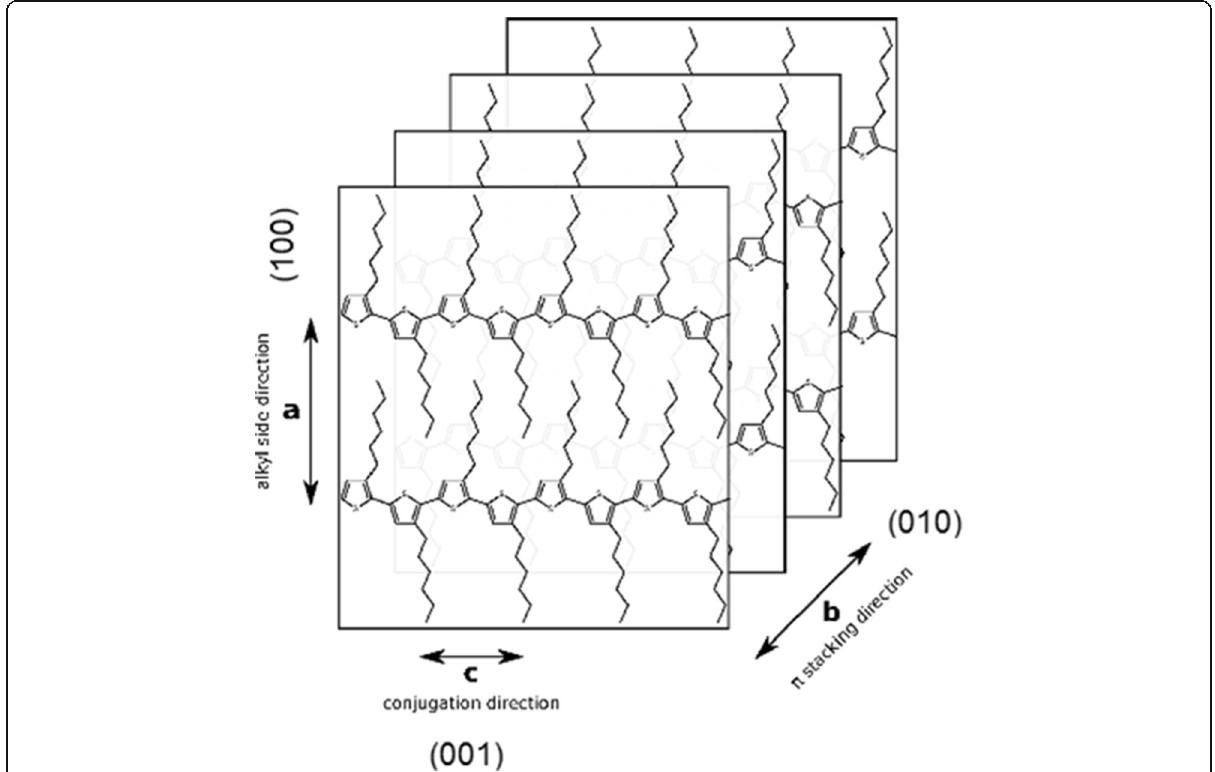
Fig. 6 Scheme of the crystalline structure of